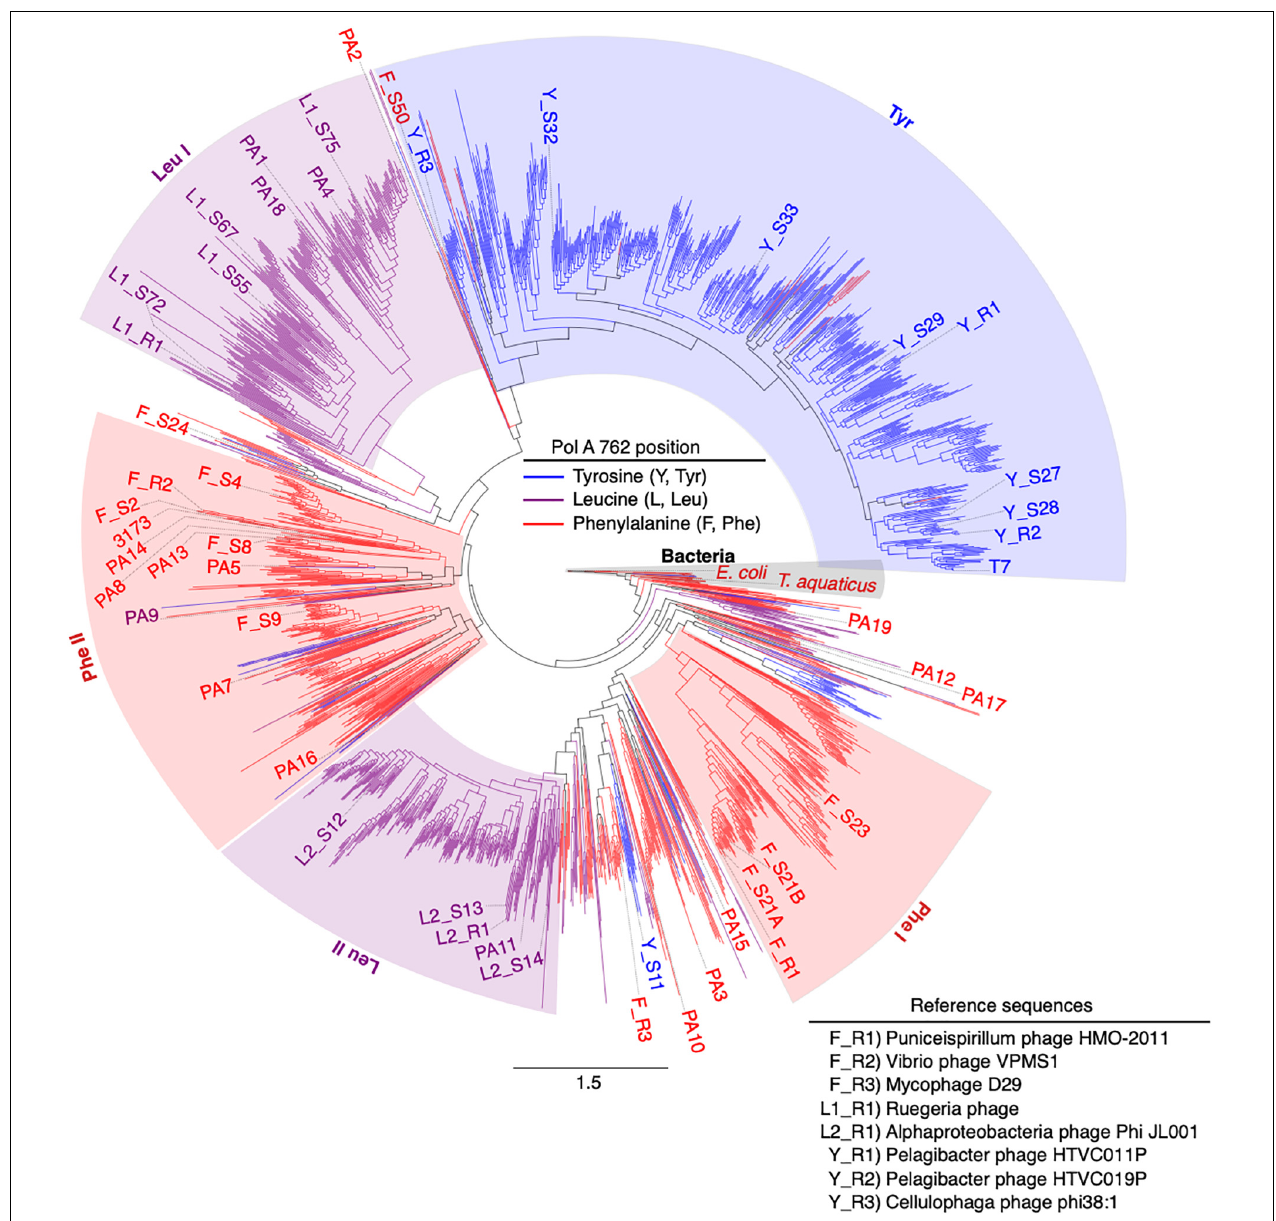
FIGURE 1 | Synthesized family A DNA polymerase sequences span phylogenetic diversity. Approximate maximum likelihood tree of 2,130 PolA amino acid sequences trimmed to the region of interest (DNA_pol_A Superfamily, acc. cl02626), the polymerase domain. Branch coloring indicates residue identity at the 762 position within the protein sequence. Synthesized reference and virome sequences are labeled by 762 residue monophyletic clades [leucine, Leu I or Leu II; tyrosine, Tyr; (Nasko et al., 2018)] with two additional paraphyletic groups identified in this analysis (phenylalanine, Phe I or Phe II). Phe I and Phe II. Bacterial reference sequences clustered toward the root of the tree are shaded in gray. All synthesized sequences are labeled by source (reference, R; virome, S; or IMG/M database, PA). PolA with previously published biochemical characterization are labeled separately (T7, E. coli , 3173, and T. aquaticus ). Scale bar represents the number of amino acid substitutions per